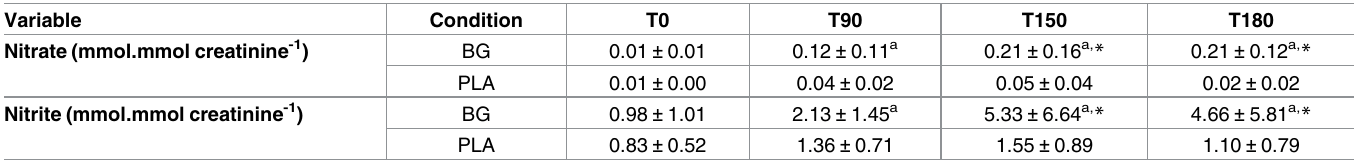
Table 2. Values of nitrate and nitrite in both beetroot-based gel and nitrated-depleted gel conditions.